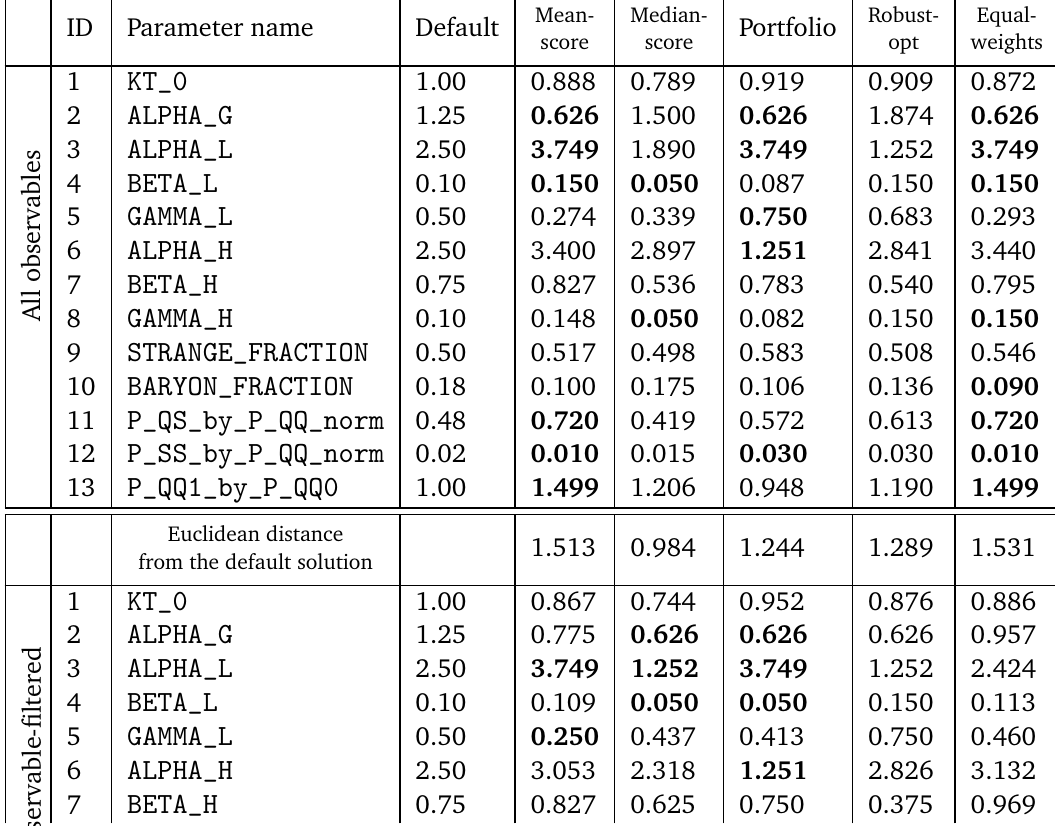
Figure 6: Cumulative distribution function (CDF) of all bins (y-axis) in the S HERPA dataset at different bands of variance levels (x-axis) given by r This function is a normal CDF with mean 1 and a different standard deviation for each method. Table 10: Optimal parameter values obtained with all methods using rational approx- imation when no filtering (88 observables used), observable-filtering (3 observables were filtered out), and bin-filtering (7 bins were filtered out) was applied. The pa- rameter values on the boundaries of the parameter space are indicated in